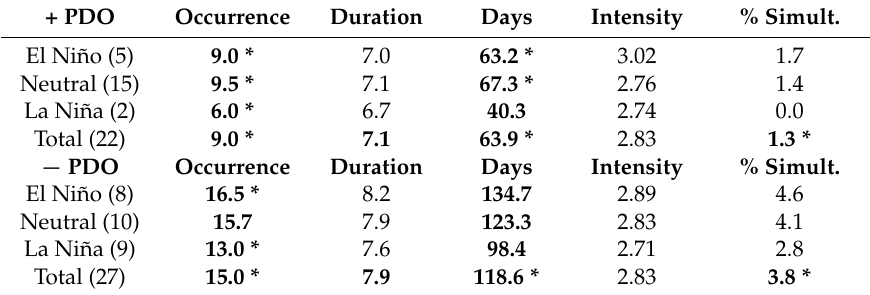
Table 7. As in Table 4, except for SH blocking events.